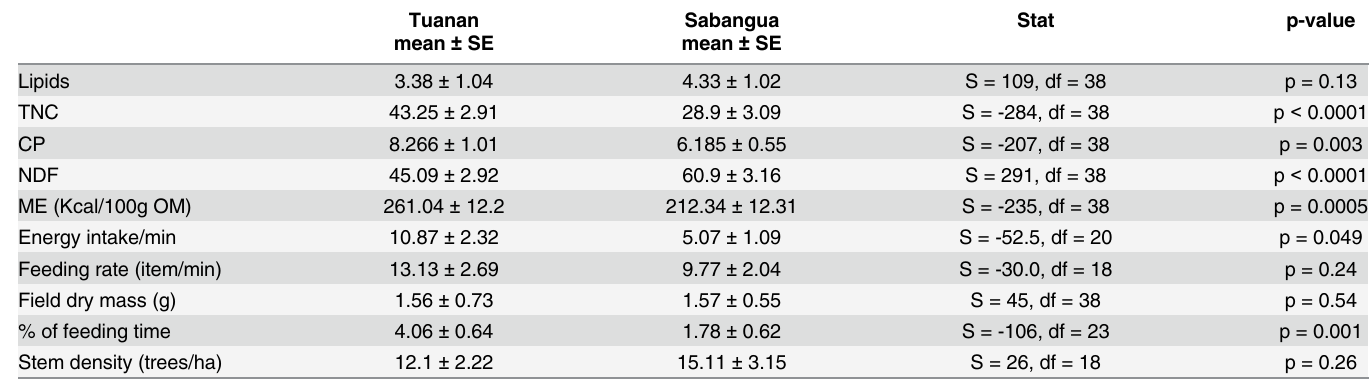
Table 2. Variation in macronutrients, metabolizable energy (ME) (expressed as % OM), and measures of availability in matched plant items in Sabangau (S) and Tuanan (T). Matched Wilcoxon Rank Tests were used to compare the two sites. TNC = Total non-structural carbohydrates; CP = Crude Protein; NDF = Neutral Detergent Fiber; ME = metabolizable energy. Means and standard errors along with sample size (n) are reported (n = 39 unless